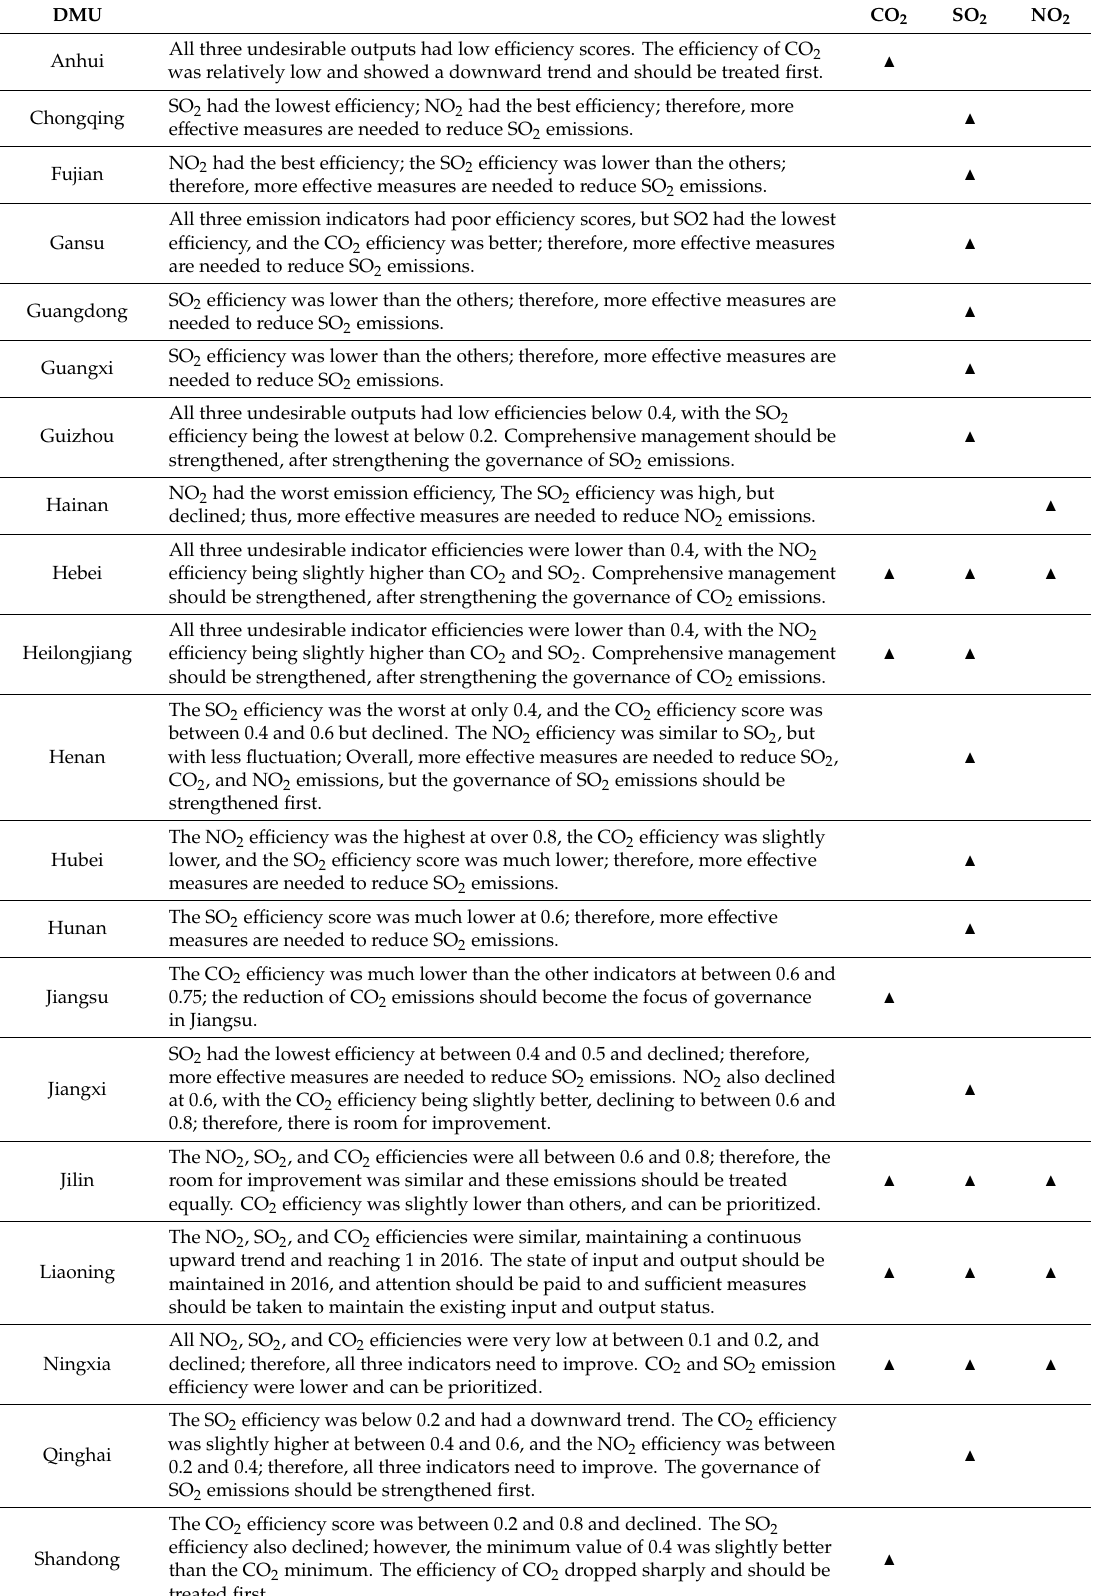
Table 11. Impact and analysis of the contaminant e ffi